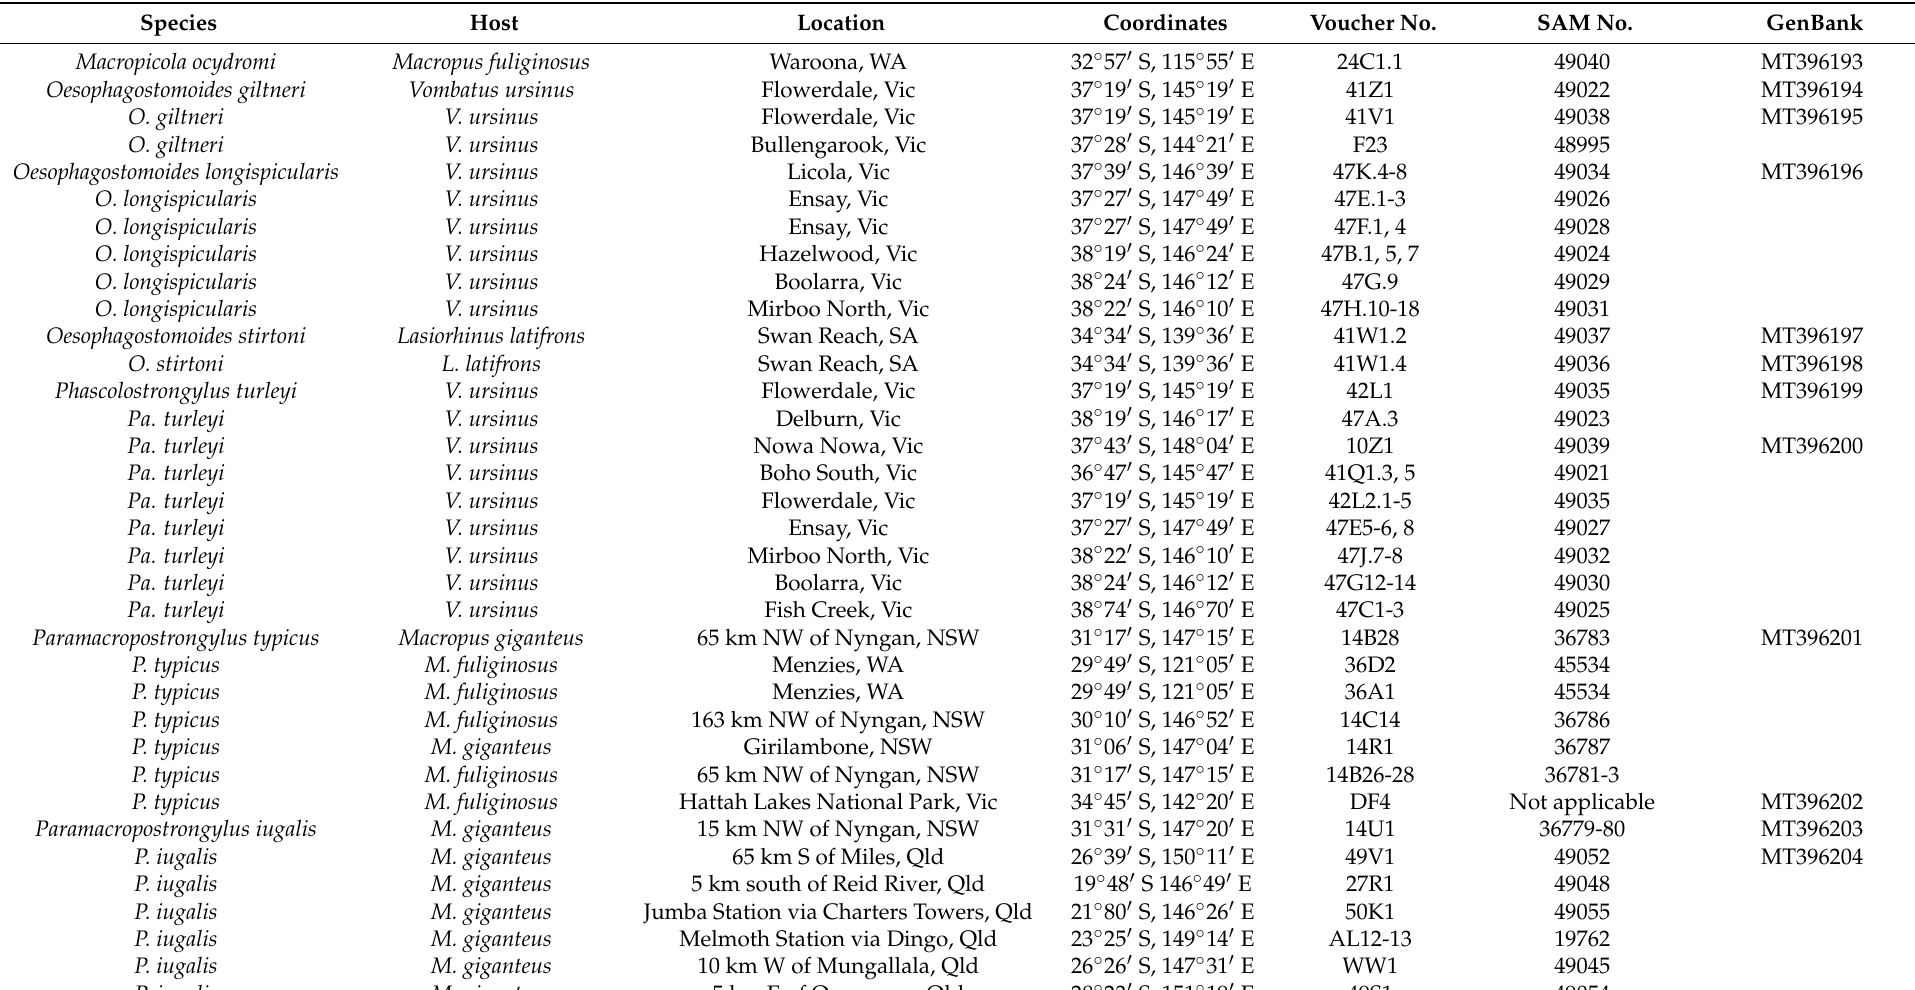
Table 1. Species within the subfamily Phascolostrongylinae included in the current study shown with information of the host and localities from which they were collected. The GenBank Accession numbers of the unique ITS + sequences are also included in addition to the SAM